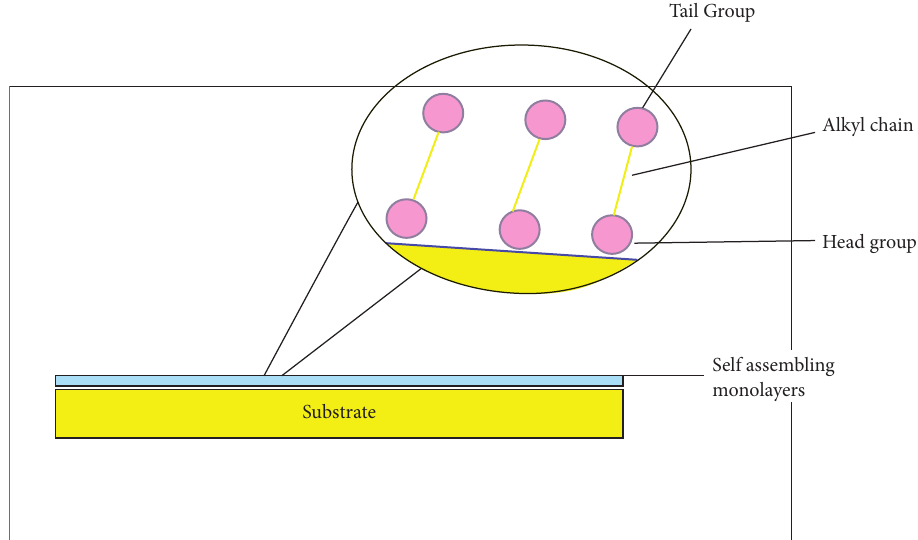
Figure 8: Self-assembled monolayer (SAM) is an ordered assembly of organic molecules with a headgroup which interacts with a solid substrate to form a stable monolayer film and a tuneable tailgroup.